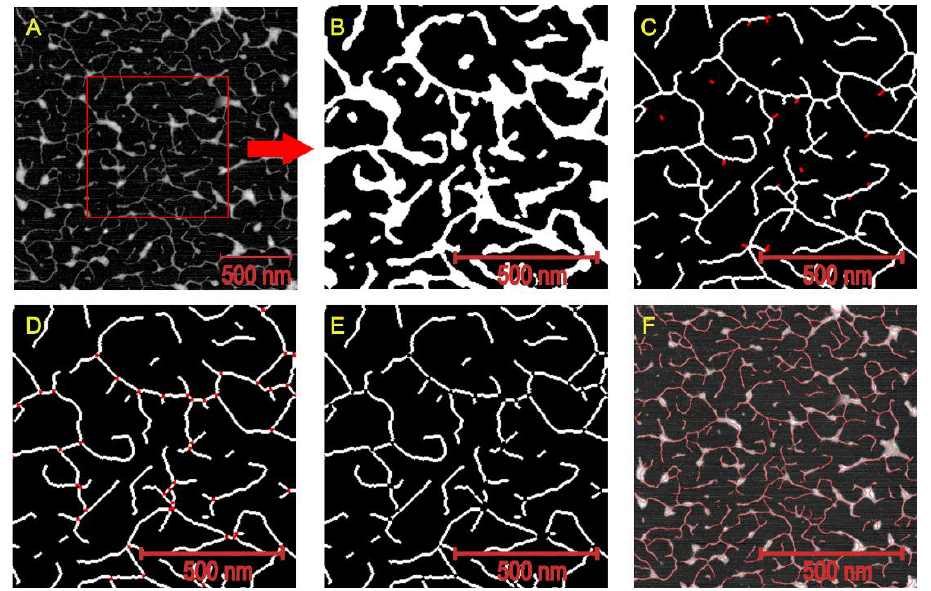
Figure 7. AFM image of DASP and subsequent stages of image analysis: ( A ) raw AFM image, ( B ) results binary thresholding and median filtering, ( C ) skeletonization, short side-branches and short individual molecules removal (removed objects indicated using red color), ( D ) branch points identification (red color), ( E ) object debranching, ( F ) raw image with imposed molecule skeletons.